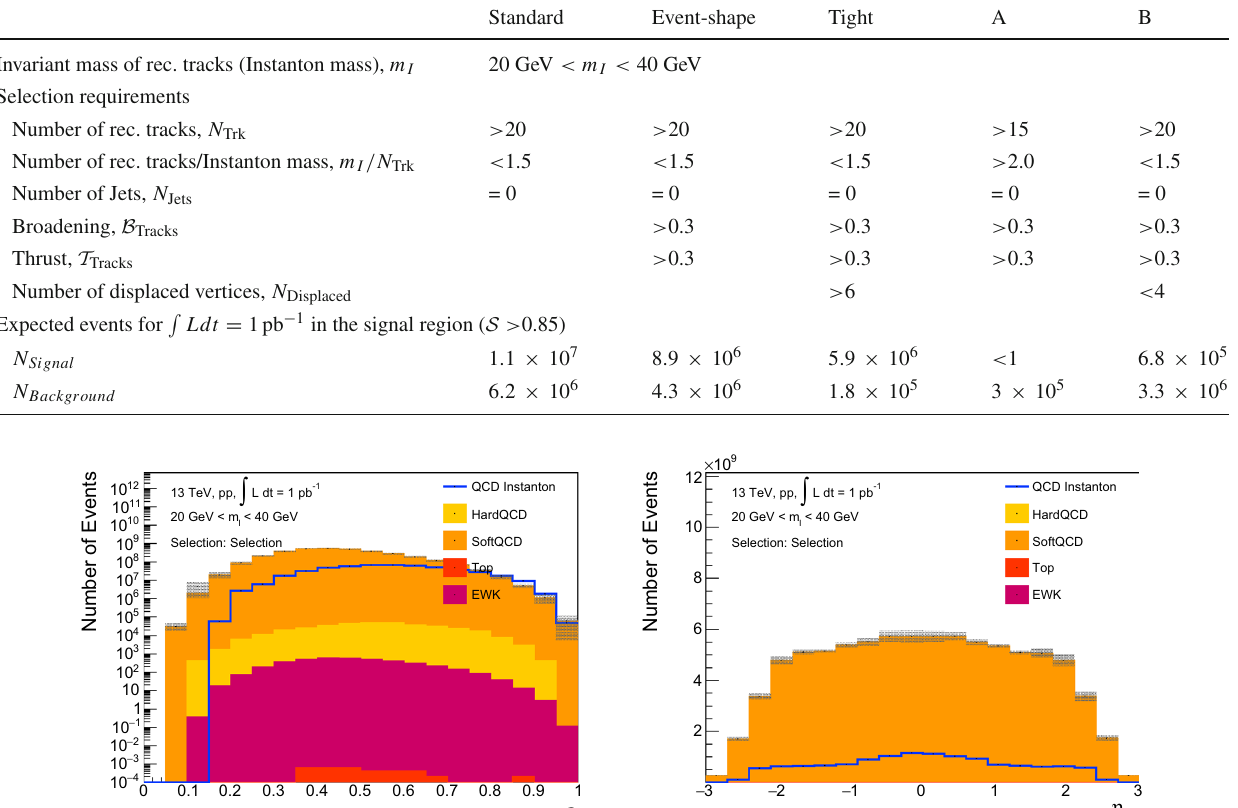
of all reconstructed tracks is required to be between 20 GeV and 40 GeV (very low mass regime). The distributions from all processes except the Instanton process are stacked. The model uncertainties are indicated as bands